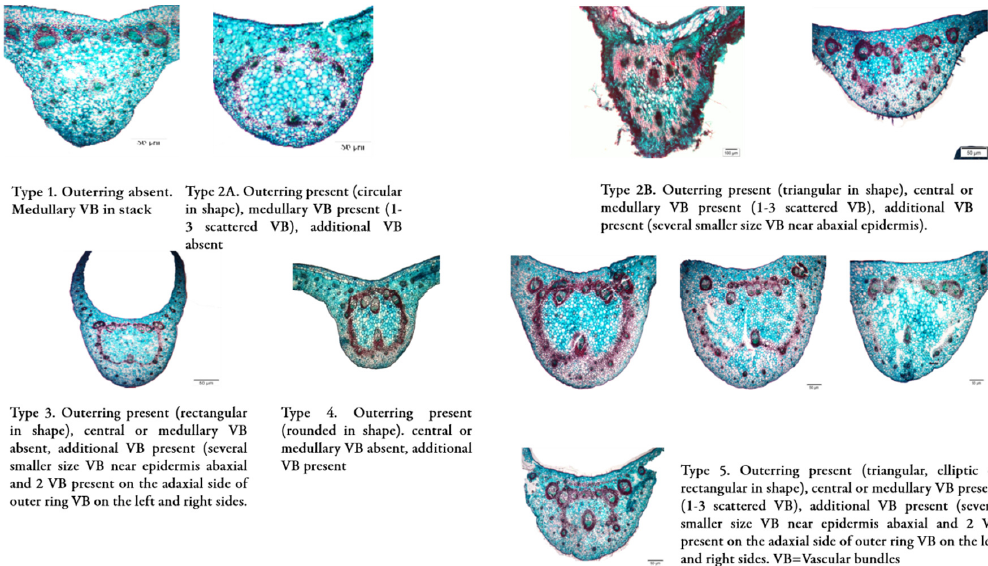
Figure 11. Variation and classification of Nepenthes vascular bundle arrangement